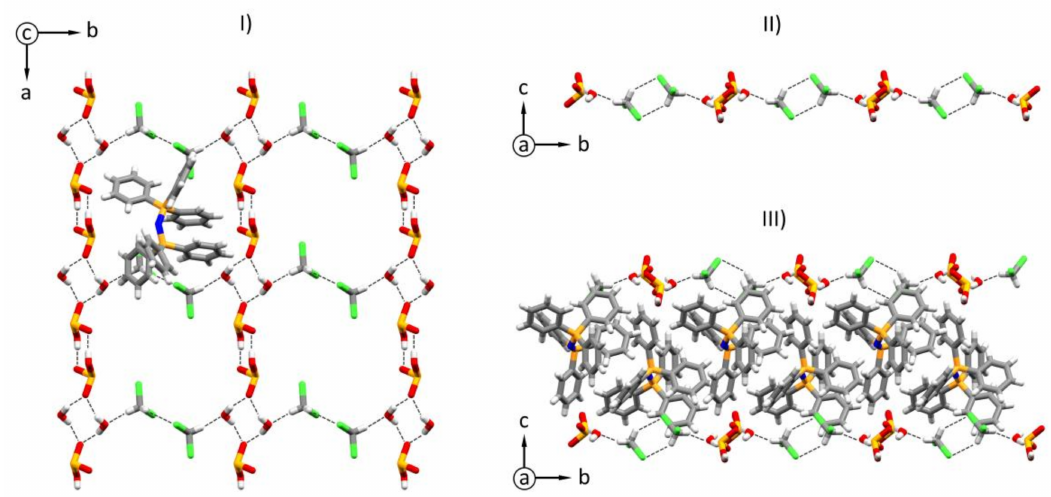
Figure 2. Supramolecular interactions in 1 . Hydrogen selenate(IV), dichloromethane and water molecules form a network of hydrogen bonds along the a and b directions (I, II). This arrangement forms square shaped apertures, where the [PNP] + cations are allocated (I; only one cation is shown for the sake of clarity), resulting in layers of cations (III). This is shown in a capped sticks